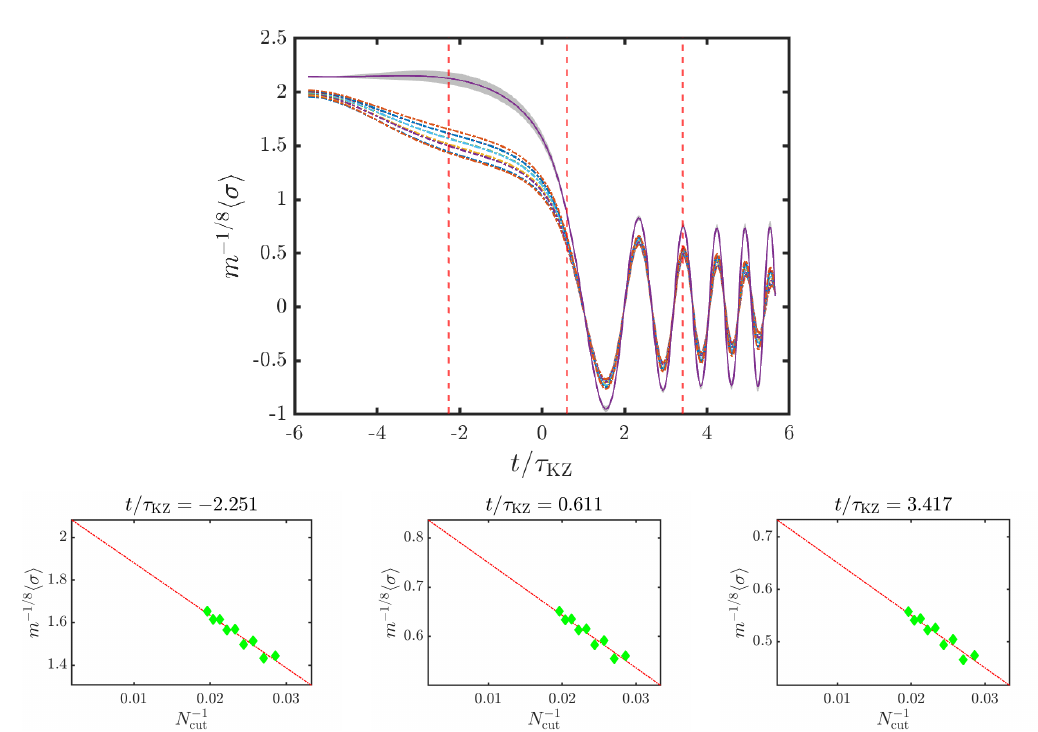
Figure C.1: Details of the extrapolation for the dynamical one-point function of the order parameter for a ferromagnetic-paramagnetic ramp along the free fermion line = 128. Raw TCSA data are plotted in dot-dashed lines in the with mL = 50 and m τ Q = 35...51. Extrapolated data main figures, the cut-off parameter is in the range N cut is denoted by solid lines, with the residual error as a grey shading. Dashed red lines correspond to the time instants that are detailed in the subplots. Green diamonds denote raw data as a function of N − 1 where − 1 is the leading exponent. Red dashed cut lines denote the fitted